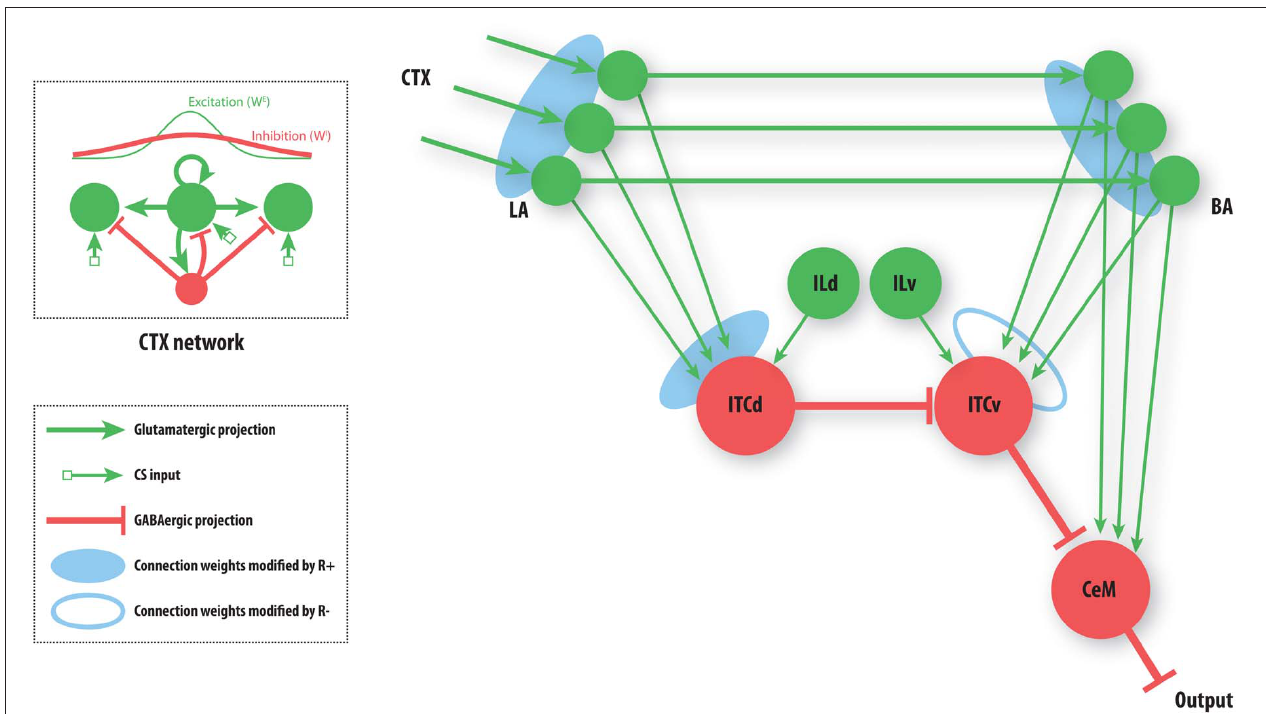
FIGURE 3 | A simplified amygdala circuit for emotional responding. An array of stimulus-related excitatory outputs from a cortical network (CTX) projects in a topographic manner to the lateral nucleus of the amygdala (LA). The cortical network (top inset) is constructed as a distance-dependent on-center off-surround network. Amygdalar input station LA sends excitatory projections topographically to the basal nucleus of the amygdala (BA). Thus, for every cortical cell there is a corresponding cell in LA and in BA, and a corresponding weight from LA onto the inhibitory dorsal intercalated cell (ITCd) and from BA onto the inhibitory ventral intercalated cell (ITCv). The whole array of excitatory LA cells